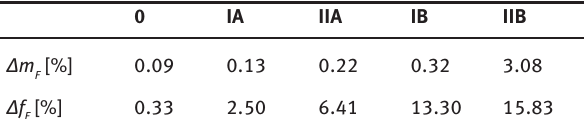
and strength decrements ∆f F